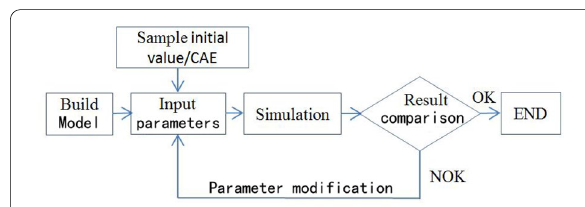
Figure 6 Finite elements of calculation grid model